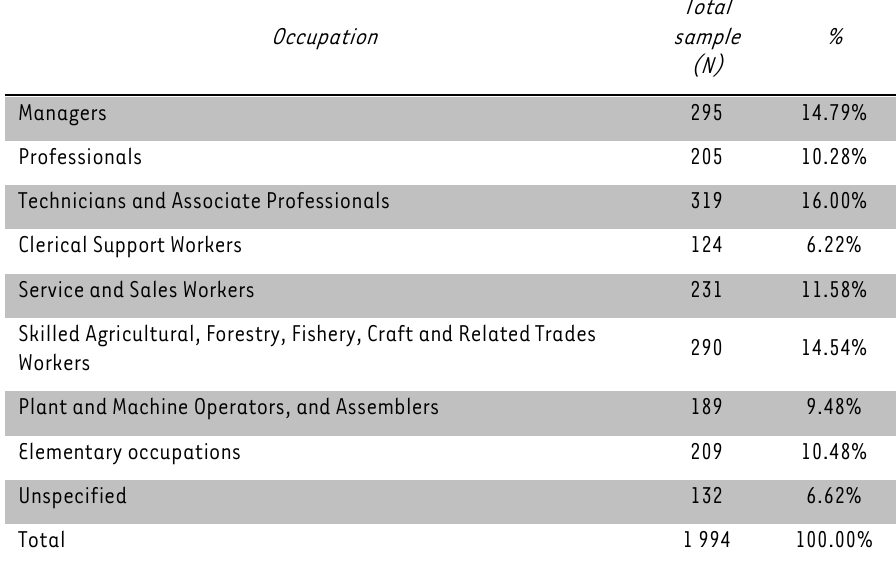
TABLE 6: Demographic profile per occupation